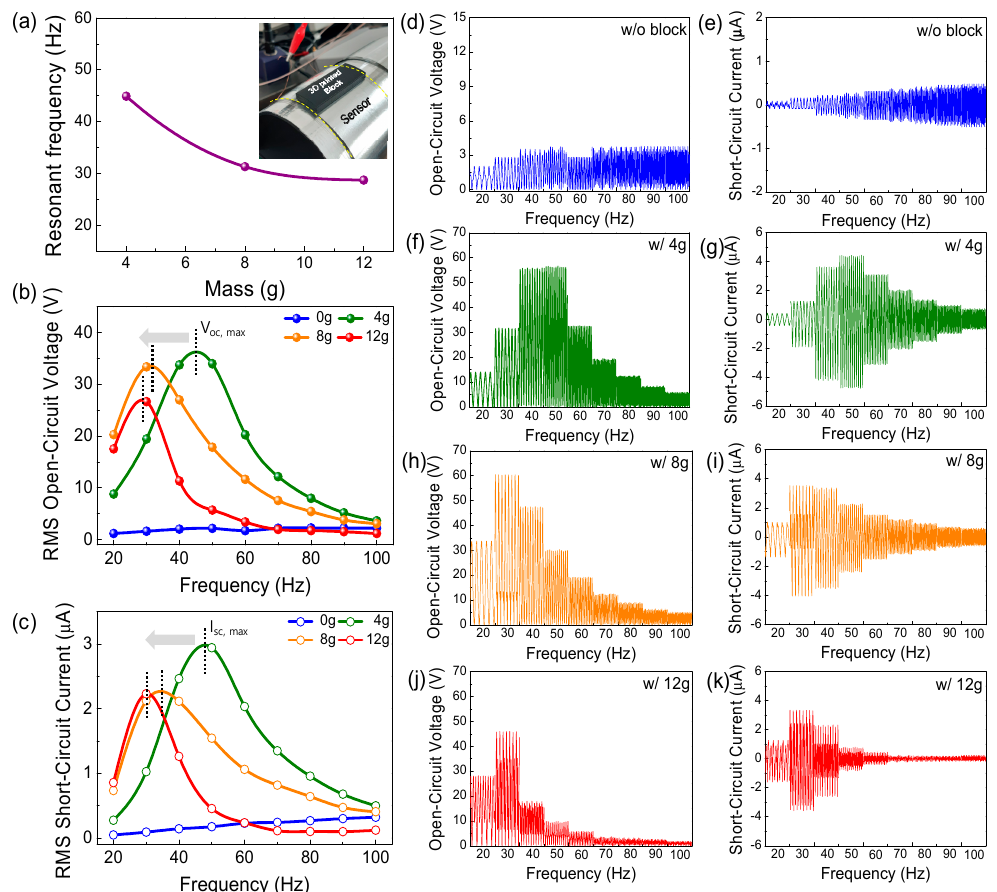
Figure 3. Output characteristics of the mass-loaded PVV sensor probe depending on the block mass: ( a ) Resonant frequency shift, ( b ) RMS open-circuit voltage (RMS V oc ), ( c ) RMS short-circuit current (RMS I sc ), and ( d – k ) Raw data of individual open-circuit voltages and currents when the block mass is ( d , e ) 0 g, ( f , g ) 4 g, ( h , i ) 8 g, and ( j , k ) 12 g.